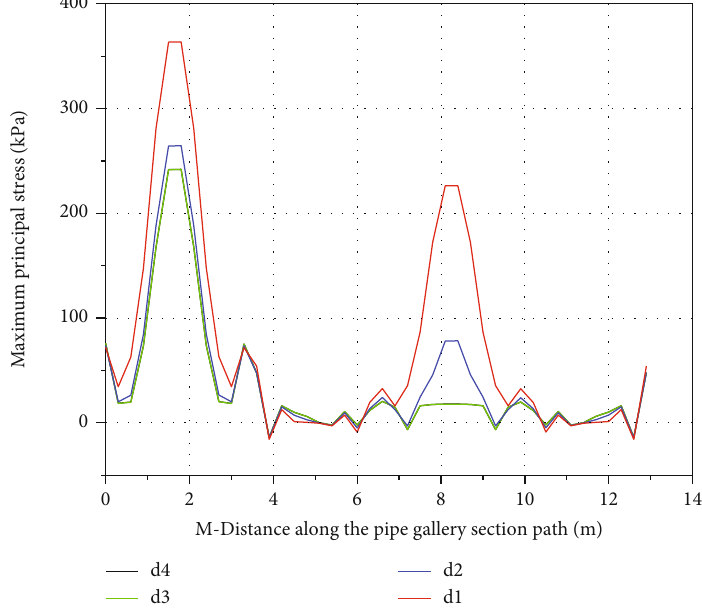
Figure 12: Distribution curve of maximum principal stress on the M side.